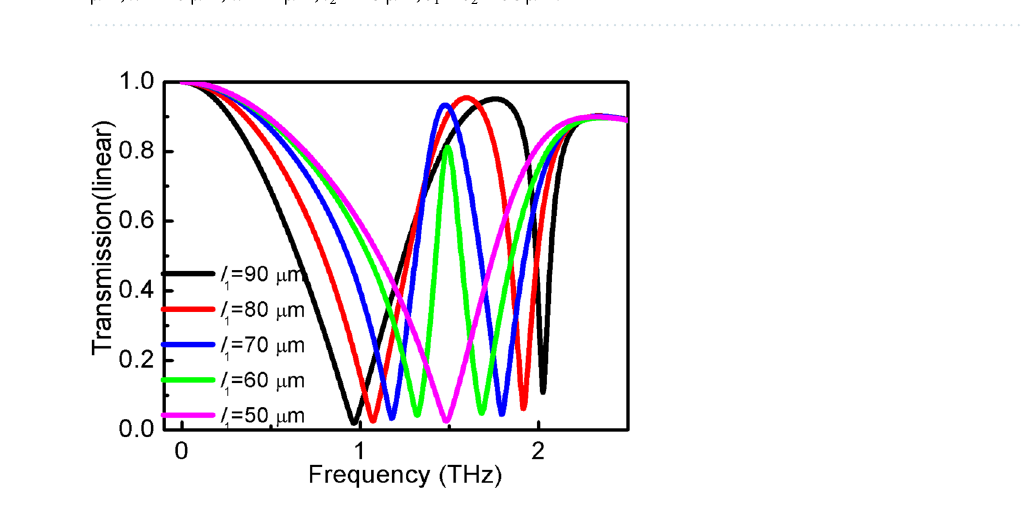
= 20 μ m, s = s = 38 μ m. 2 1 2